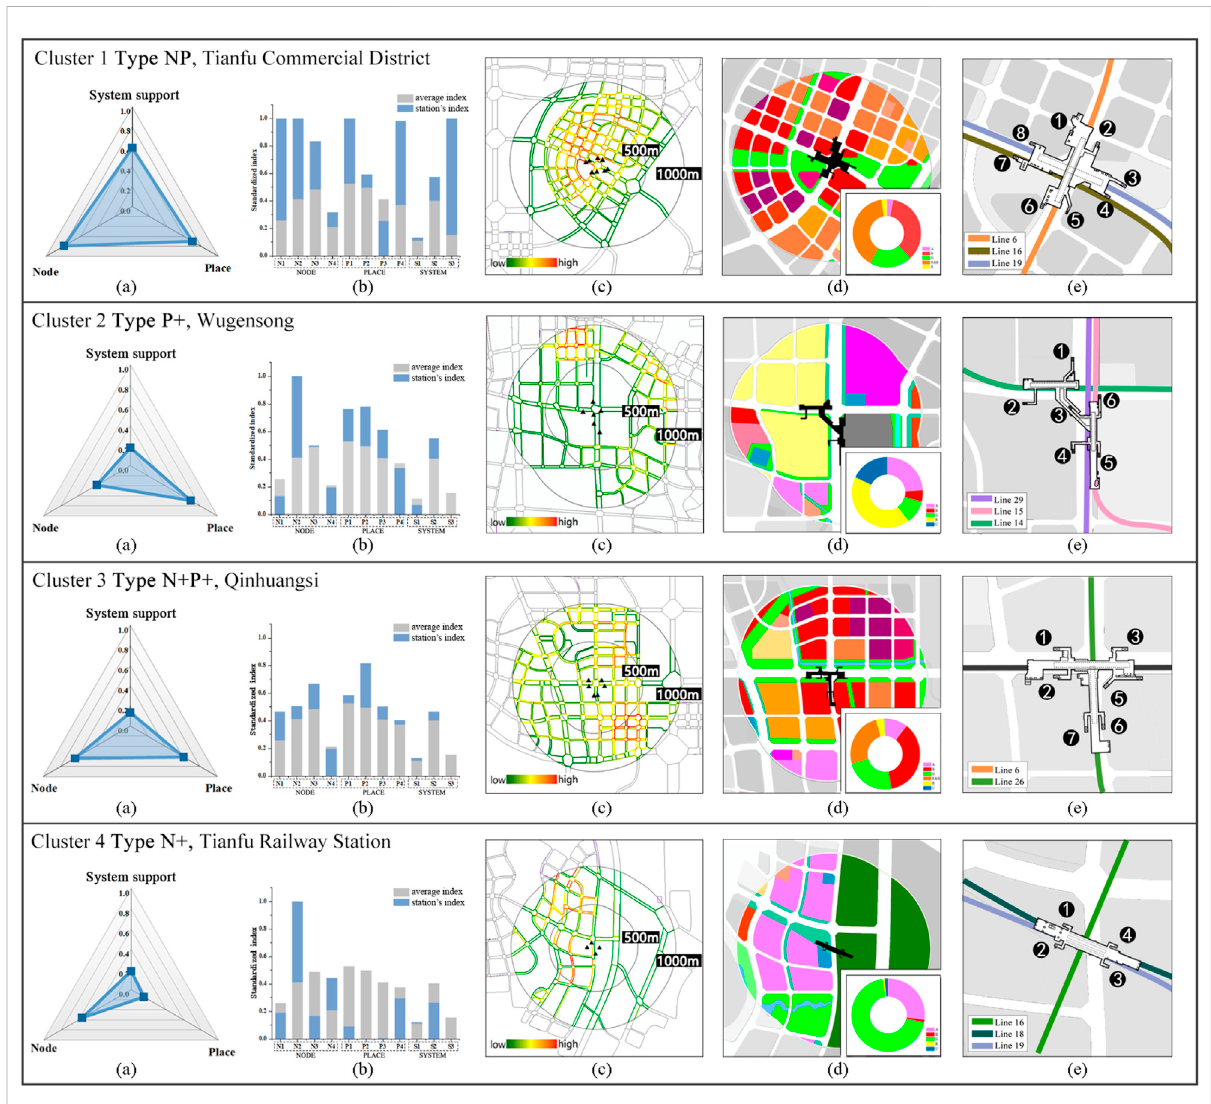
FIGURE 9 Typical Case Analysis (A) values of node, place, and design indexes for each typical case; (B) comparison of indexes of each typical case with average indexes; (C) road accessibility; (D) land use in the regulatory plan; (E) station